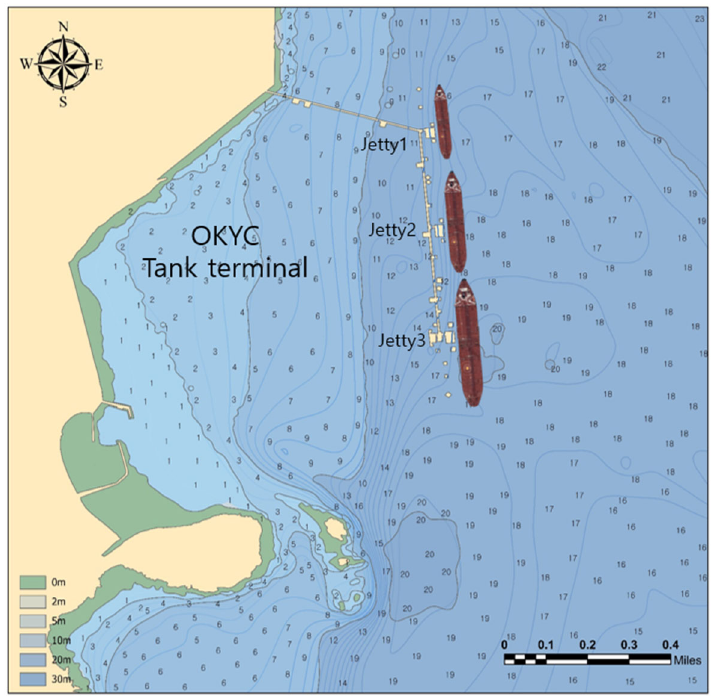
Figure 6. Terminal numerical chart.